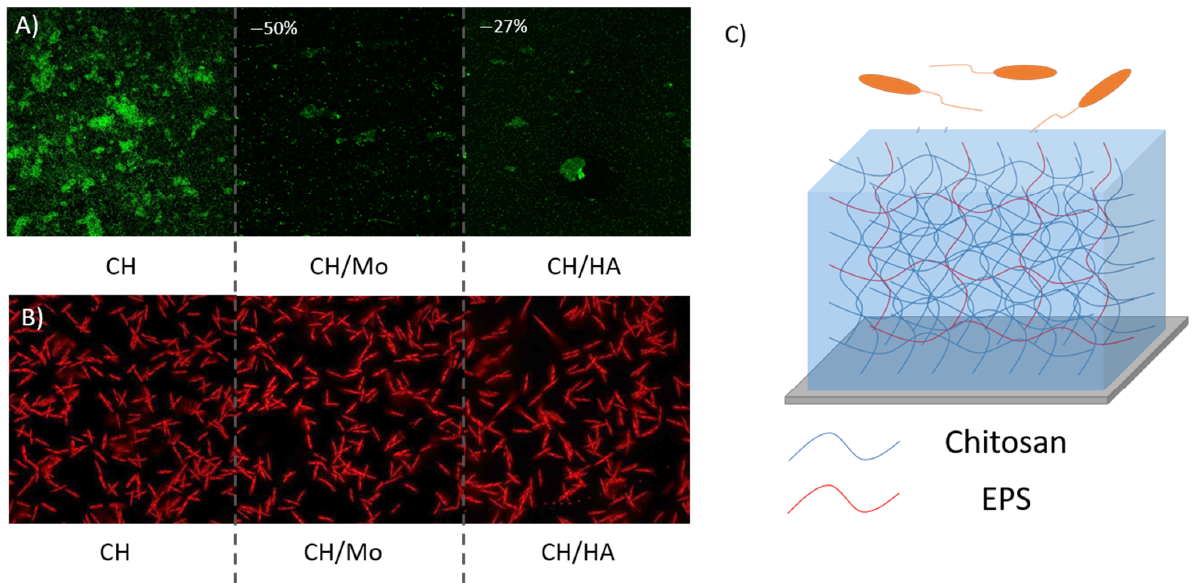
Figure 9. Confocal laser microscopy observations of CH, CH/Mo, and CH/HA coatings and the adhesion of ( A ) V. harveyi at a flow of at 1 mL/min at 10 8 cells/mL for 4 h in ASW at 20 ◦ C, values represent the percentage of adhesion inhibition ( B ) C. closterium at 10 5 cells/mL in static conditions for 72 h in ASW medium complemented with F/2 silica nutrients at 20 ◦ C, ( C ) schematic representation of anti-adhesive coatings. Bacteria were stained with Syto9 ®